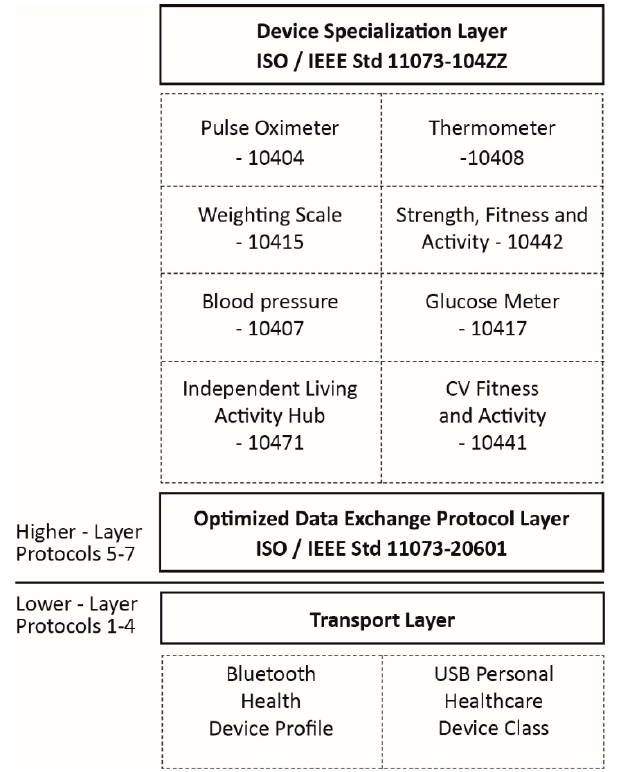
Figure 8. The Continua open systems interconnection (OSI) 7-layer construct with respective Multimodal Technol. Interact. 2020 , 4 , x FOR PEER REVIEW standards (Adapted from Carroll et al. [52] and Moorman [51]). (Adapted from Carroll et al. [52] and Moorman [51]).